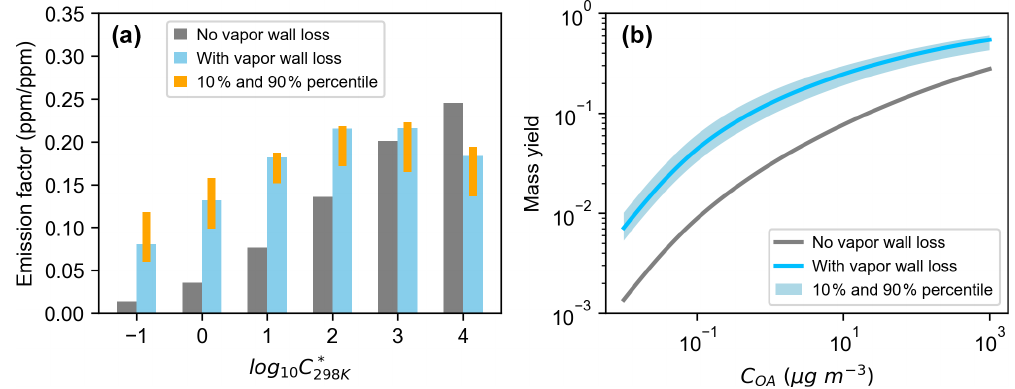
Figure 3. Optimized yield factors (a) and the mass yield of SOA from biomass burning at 298K (b) with and without vapor wall loss correction. The blue bars (a) and line (b) with vapor wall loss refer to median chamber conditions with k w = 0 . 0033s − 1 and C wall = 5mgm − 3